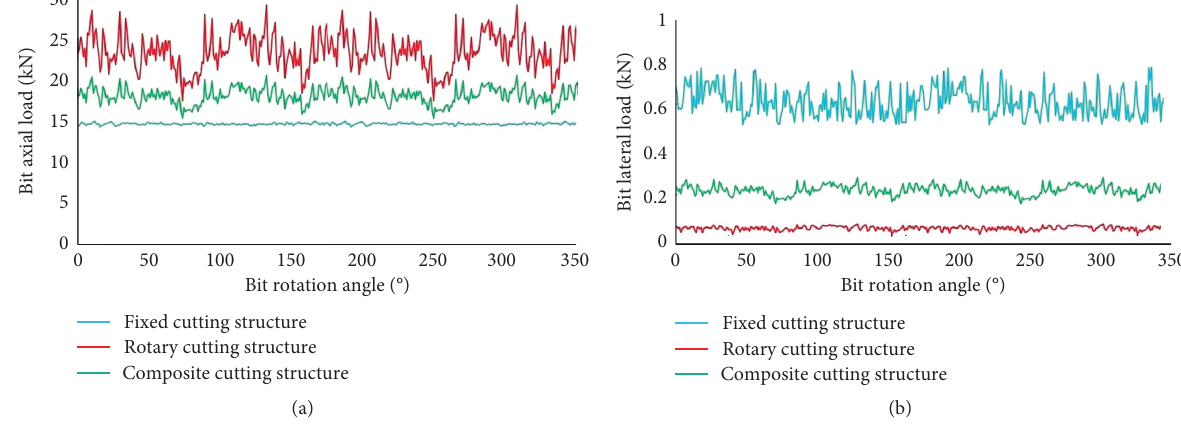
Figure 9: Comparison of drill bit axial and transverse loads. (a) Bit axial loads. (b) Bit lateral